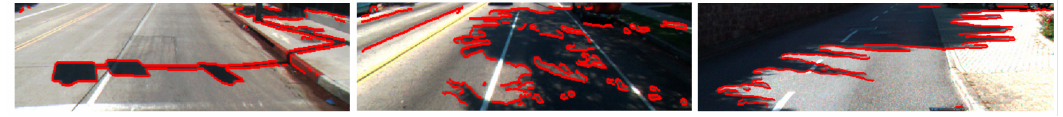
Figure 14. Shadow edge detection results of images in Figure 12 obtained by Property 2.